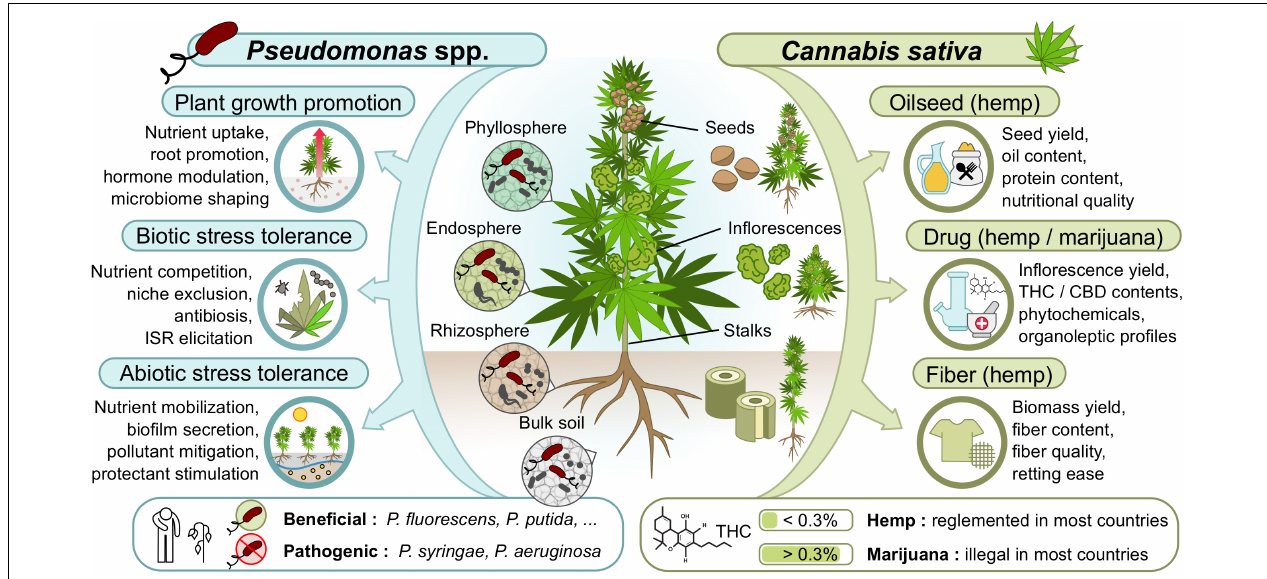
FIGURE 1 | Potential modes of action of beneficial Pseudomonas spp. inoculants and traits they could improve in cannabis